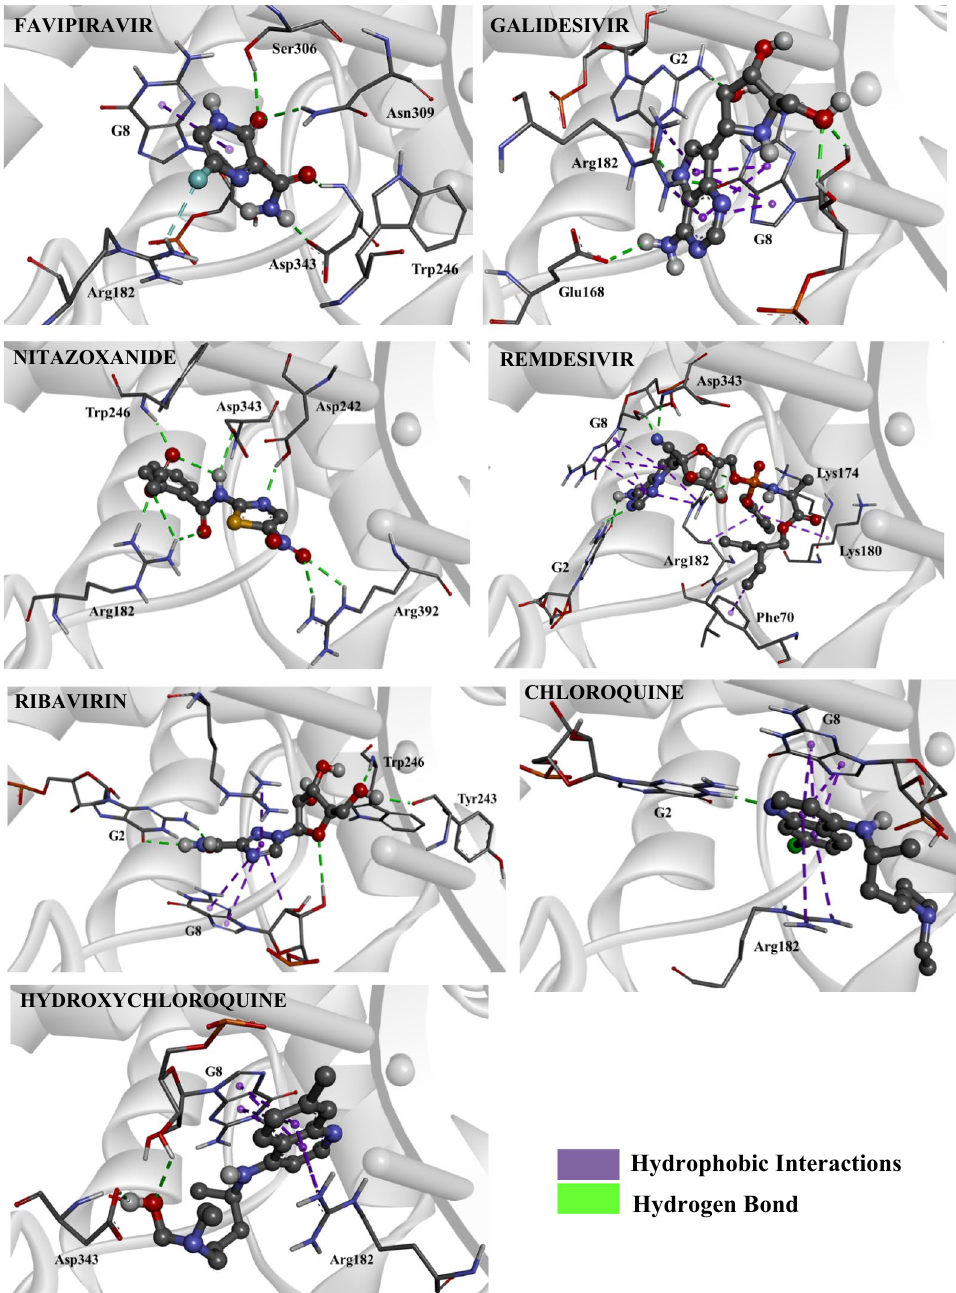
Figure 3. Intermolecular interactions of the drugs investigated in the RdRp binding site. Image generated in the Visual Molecular Dynamics 1.9.3 https:// www. ks. uiuc. edu/ Resea rch/